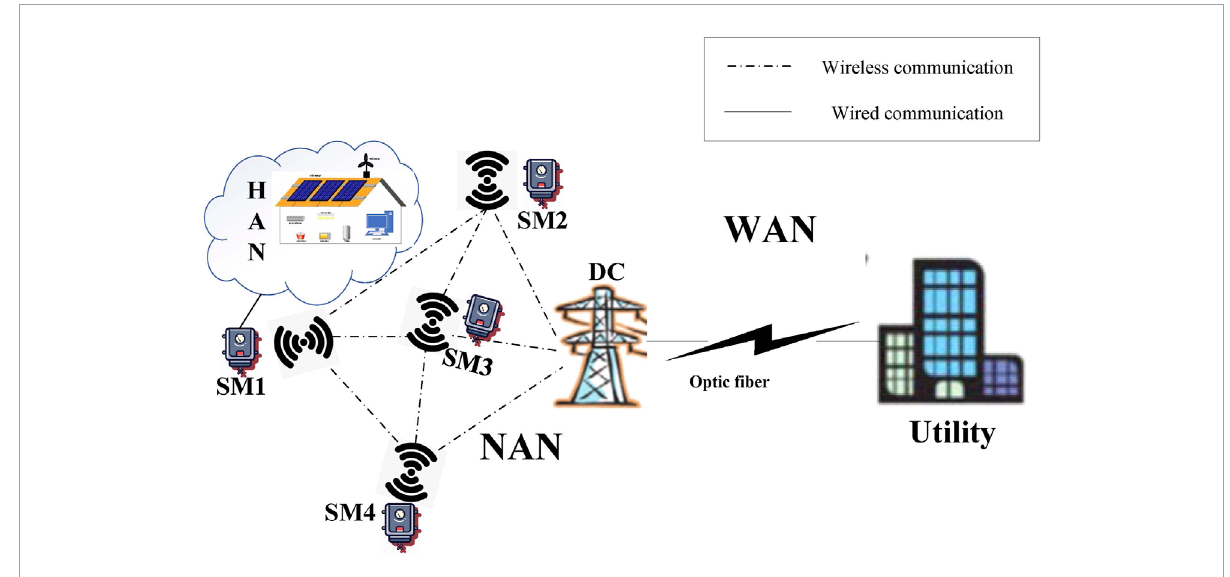
FIGURE 1 The architecture of AMI.